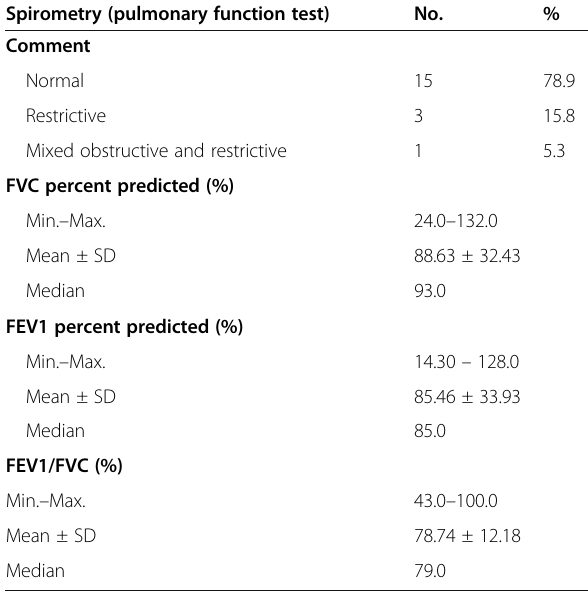
Fig. 1 Prevalence of the pulmonary complications after allogenic stem cell transplantation